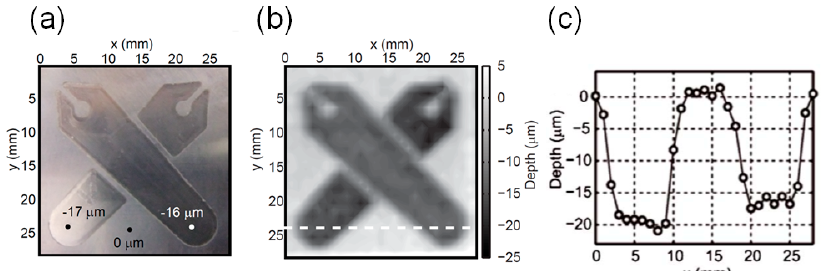
Figure 2. ( a ) Photograph of the sample. The numbers indicate the relative heights at the three positions marked with the dots; ( b ) topographic map as measured by the PS THz-TDS system developed for the T-ray topography; ( c ) cross-section of the topography data along the white line in ( b ). (Reprinted with permission from reference [66], Optical Society of America.).